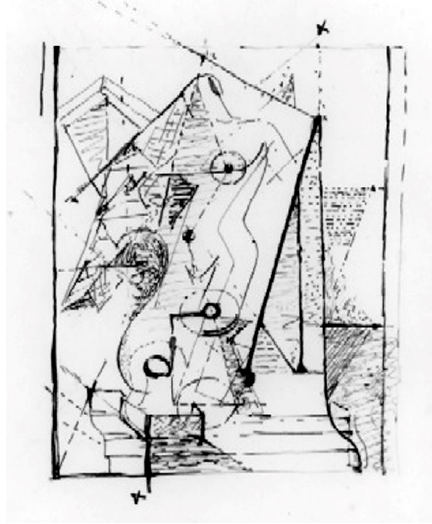
Figure 7. Automatic Drawing by André Masson (1924). Ink on paper. Photo courtesy Galerie Natalie Seroussi and used by permission.